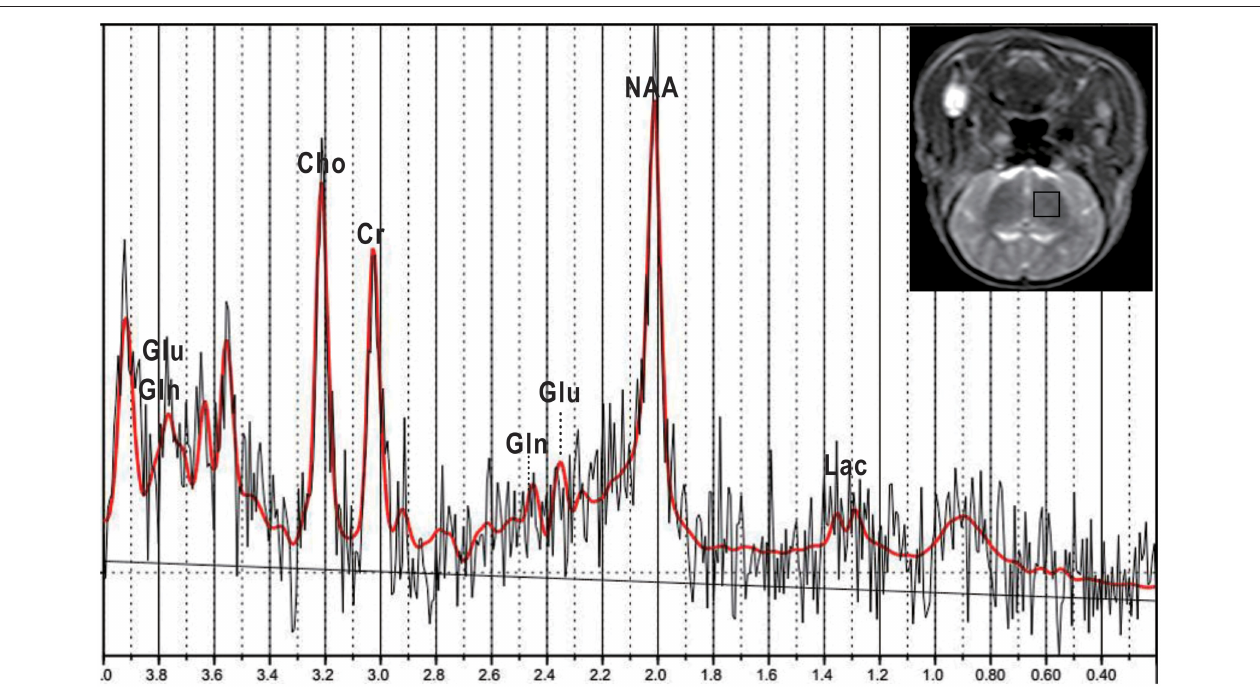
FIGURE 1 | Representative T 2 -weighted image and corresponding 1 H-MRS of a normal piglet. A MRS voxel was placed in the left basal ganglia (black square). LCModel fitting results (red), fit from 0.2 to 4.0 ppm, are presented. Glu, glutamate; Gln, glutamine; NAA, N-acetylaspartate; Lac, lactate; Cho, choline; Cr,